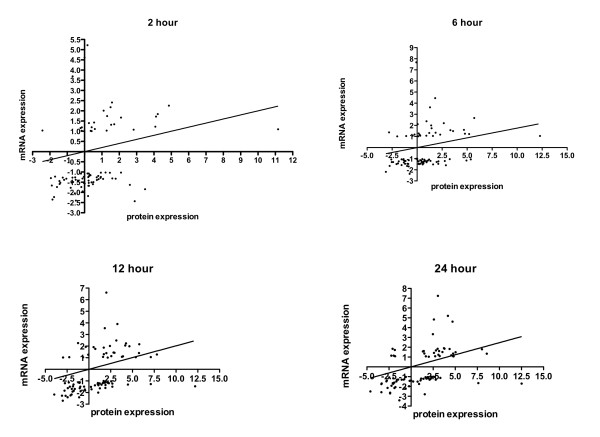
Linear regression of protein level and mRNA level. Slope and regression values are shown for all time points. Values are generally within correlated quadrants. Statistical analysis of the correlation between protein and microarray experiments shows a consistent trend of correlation among the datasets. Linear regressions were forced with X and Y-intercepts at zero, and varied between 0.18 and 0.25, with p < 0.05 for all correlations.